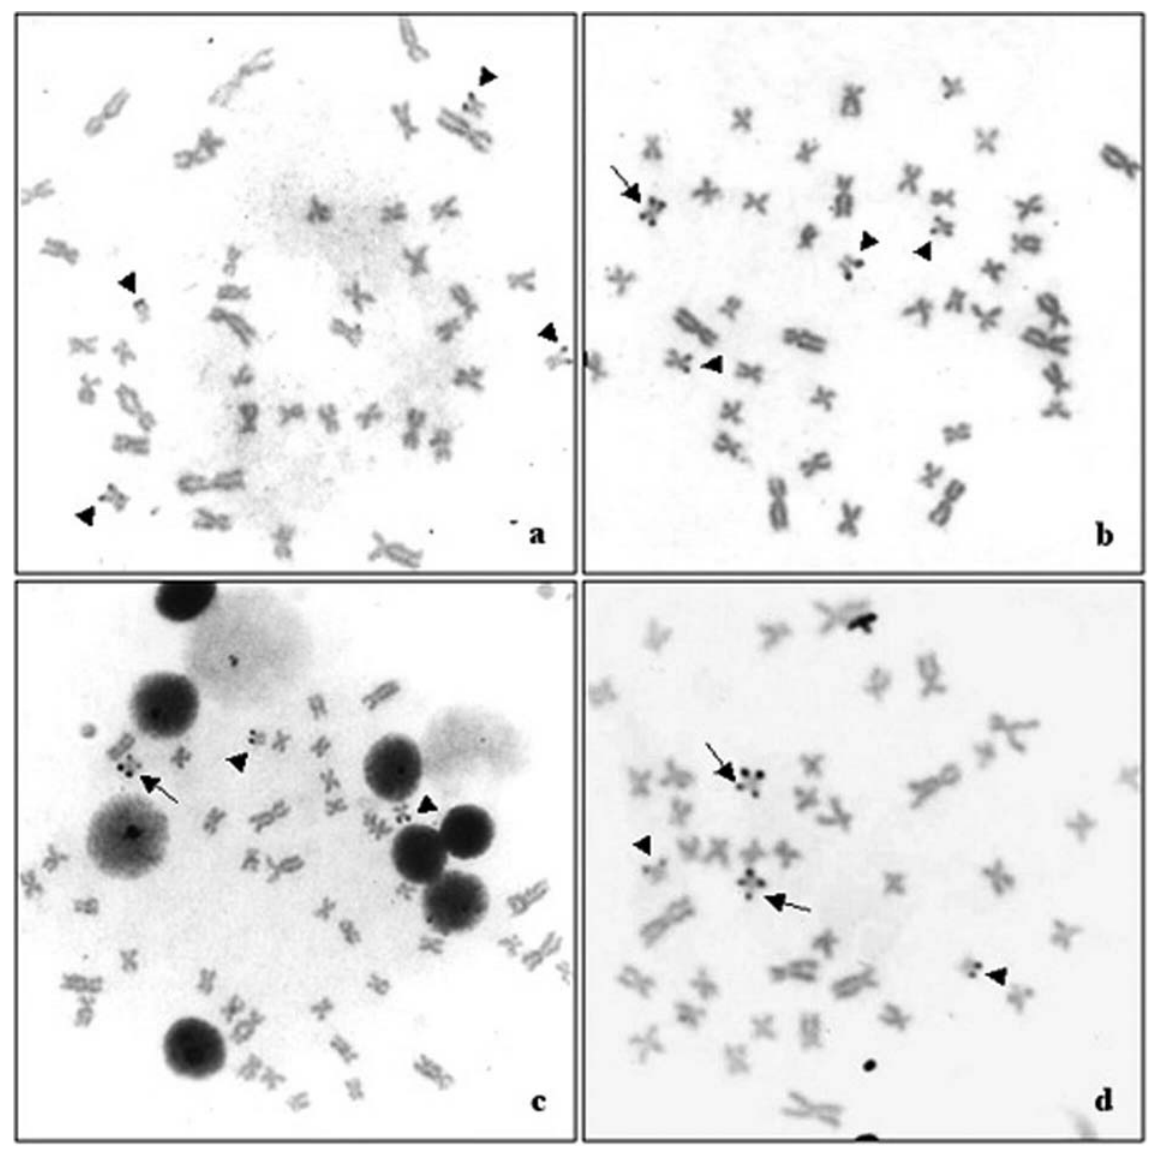
Figure 5 - Metaphases of Hoplias malabaricus from the Ribeira (a), Tibagi (b), Ivaí (c), and Iguaçu (d) populations stained with silver nitrate, showing the variability of the Ag-NOR sites. Arrows and arrowheads indicate the bi-telomeric NOR phenotype and the telomeric NORs,